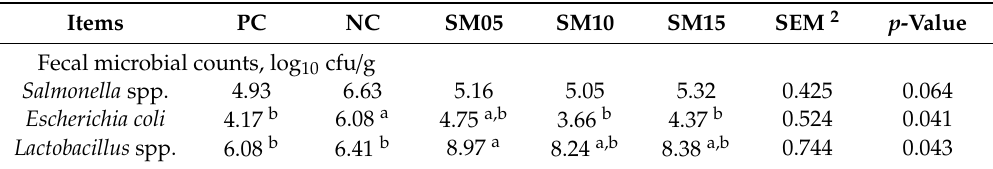
Table 6. E ff ect of spent mushroom ( C. militaris ) on microbial proliferation in weaning pigs 1 . Items PC NC SM05 SM10 SM15 SEM 2 p -Value Fecal microbial counts, log 10 cfu / g Salmonella